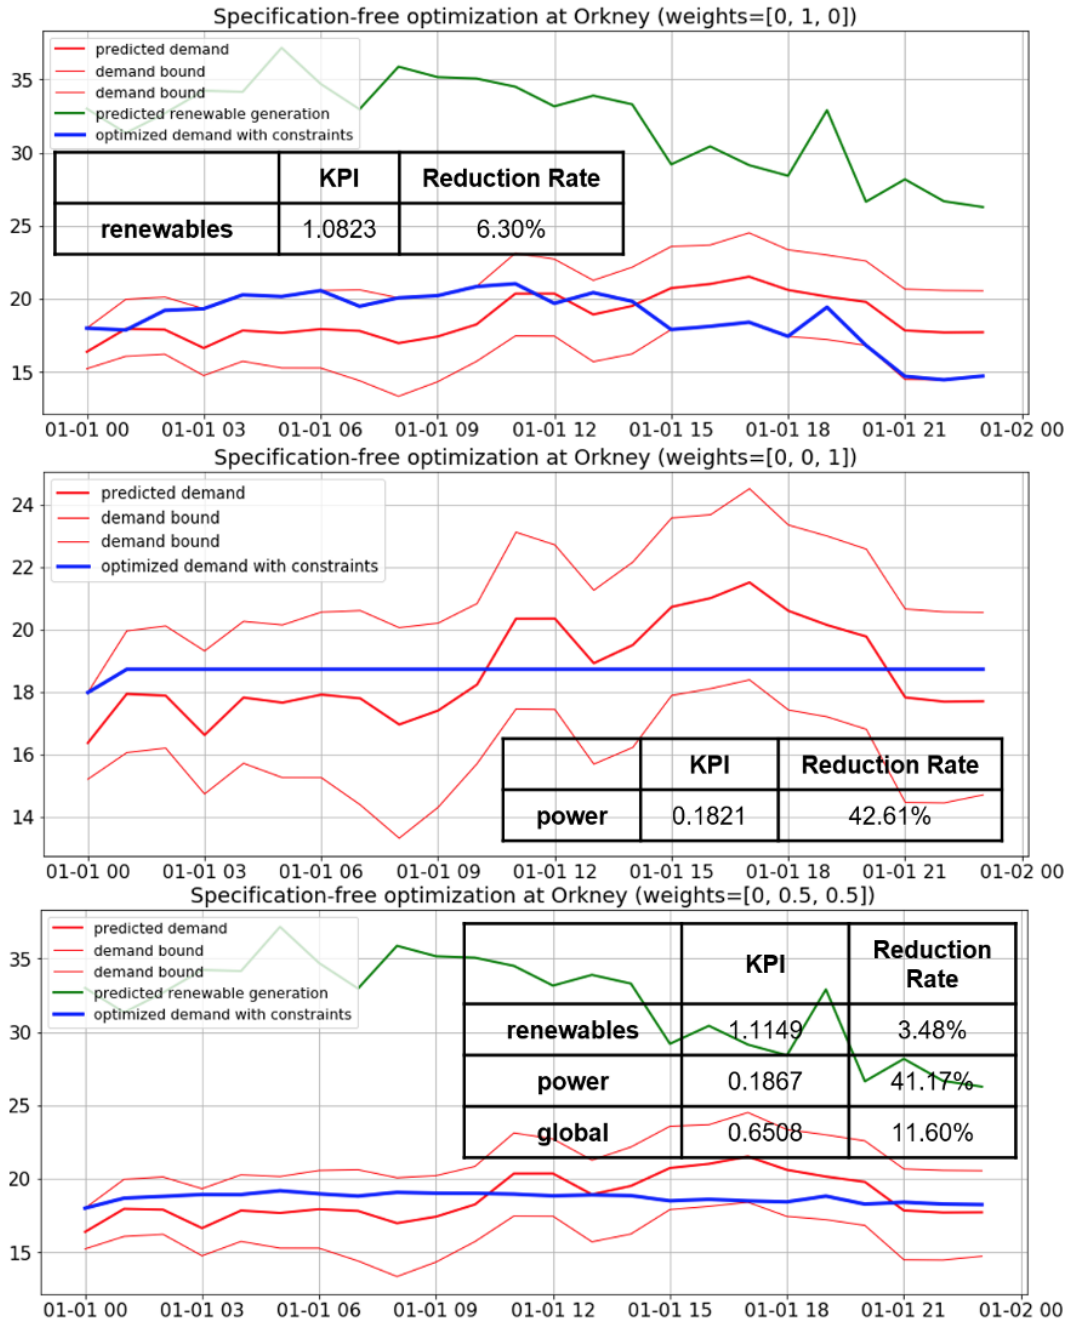
Figure 10. Examples of the application of the optimization approach to Orkney. In the titles, the weights for cost, renewables and power KPIs respectively are shown. In the vertical axis, the measurement unit is